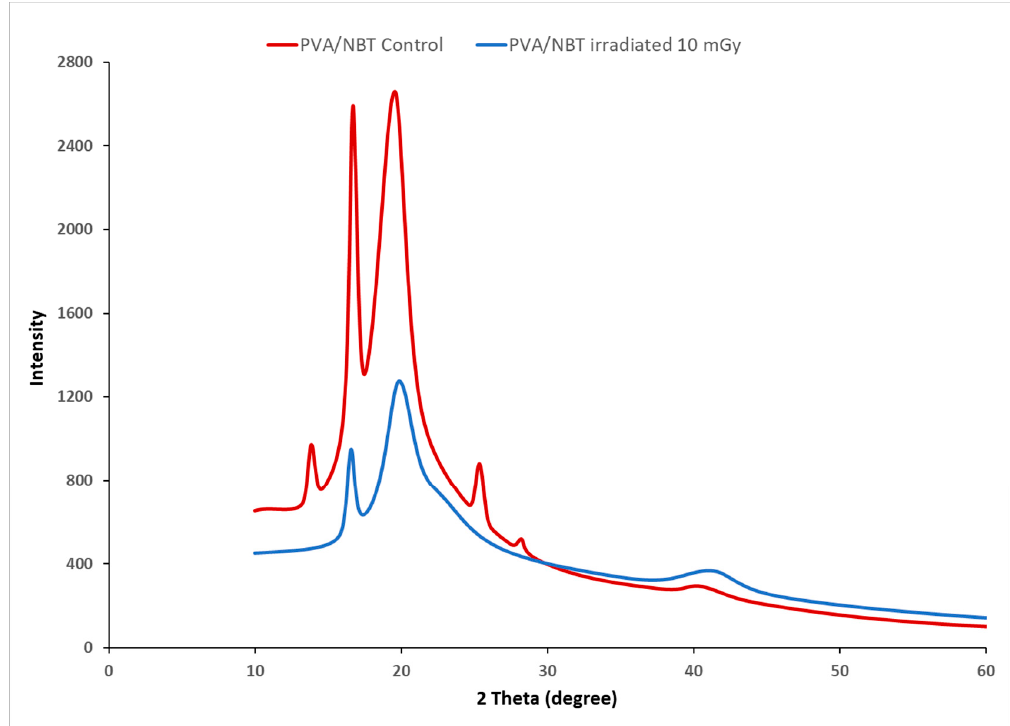
Figure 6. X-ray diffraction patterns of control and irradiated PVA/NBT films.